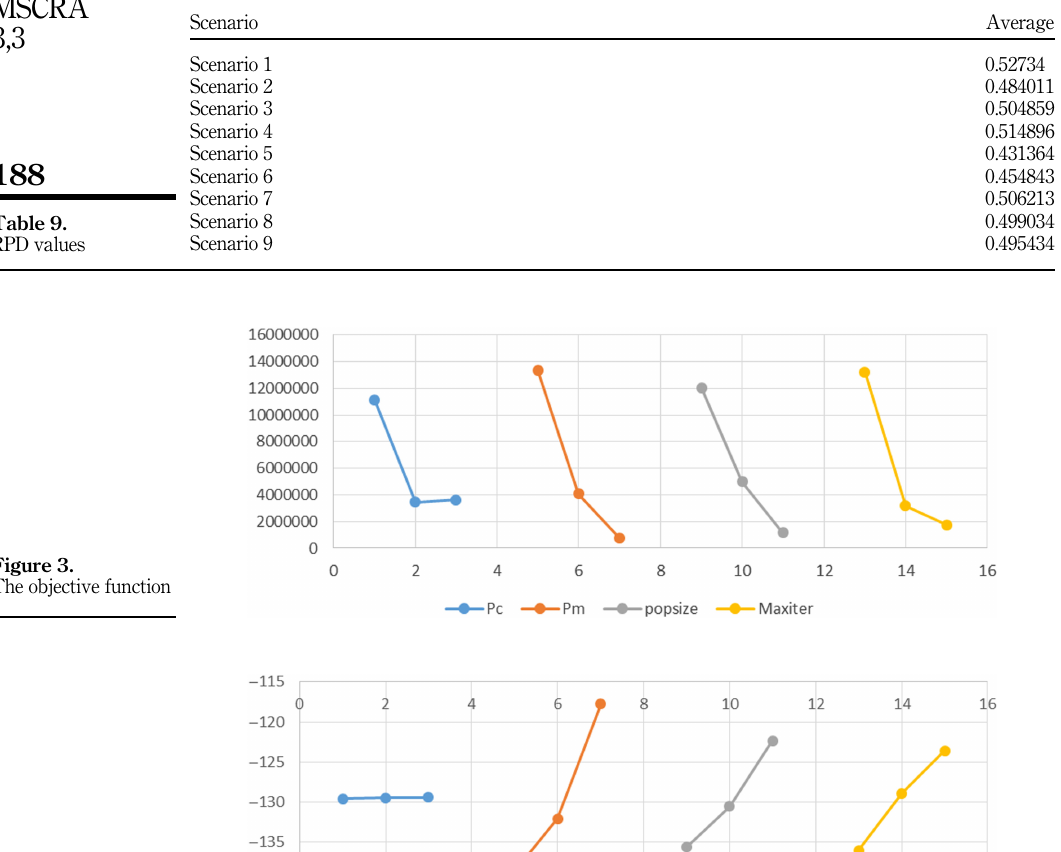
Figure 4. The S/N diagram